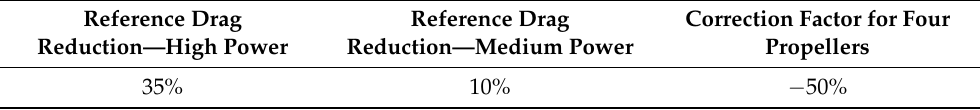
Table 2. Drag reduction through wing tip propellers